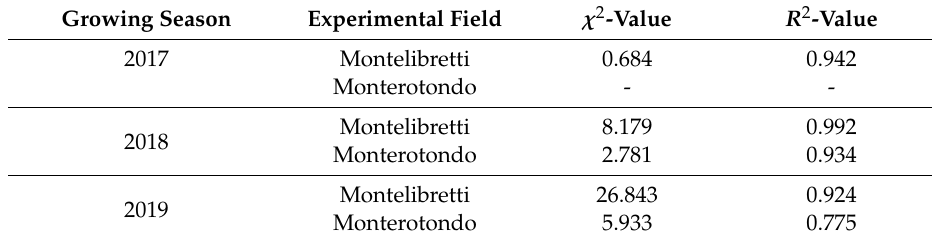
Table 3. Numerical consistence between simulations and field data of D. suzukii male populations.